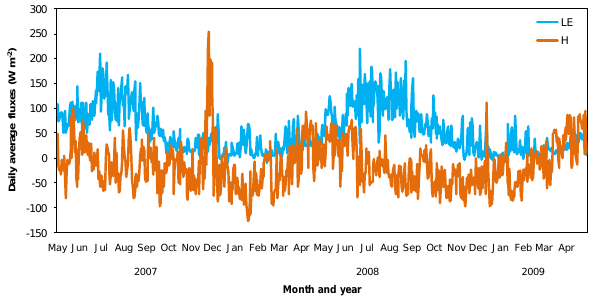
2 flux grouped by wind direction. Larger segments represent greater half-hourly average CO 2 flux detected from the corresponding wind direction and thus upwind vegetation. Total fluxes do not necessarily fol- low these seasonal patterns since wind direction is not evenly dis- tributed: the prevailing direction is